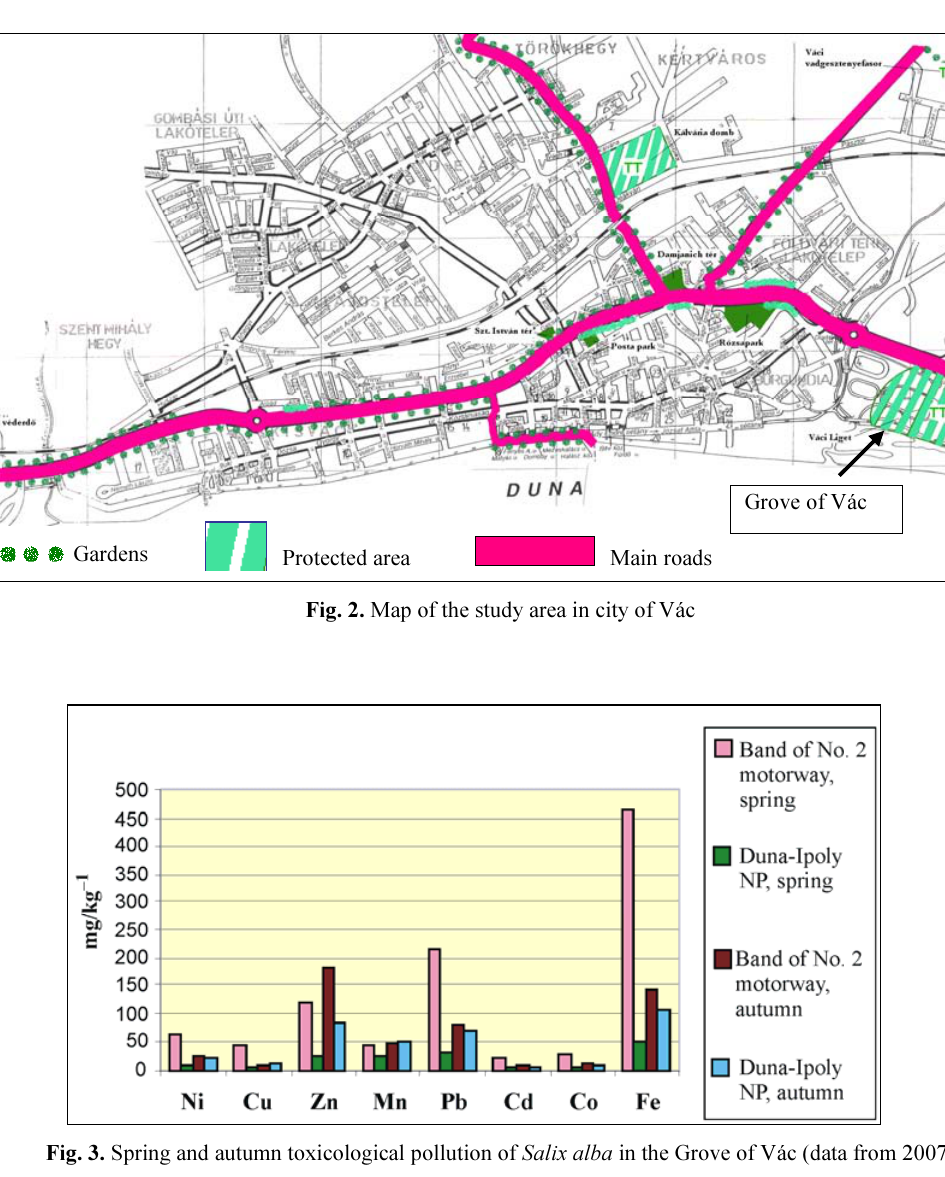
Fig. 3. Spring and autumn toxicological pollution of Salix alba in the Grove of Vác (data from 2007)